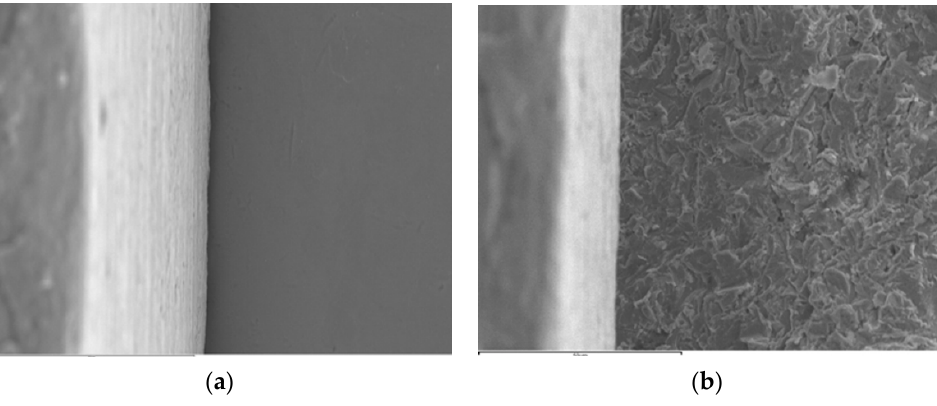
Figure 1. SEM images (1000×): ( a ) AM 4 V specimen, ( b ) AS 2 V